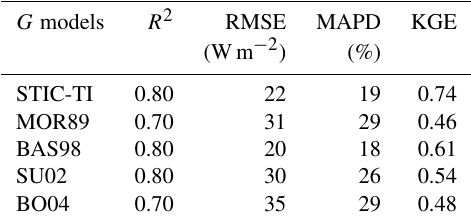
Table 4. A comparison of error statistics of G i estimates from STIC-TI and existing G i models over different